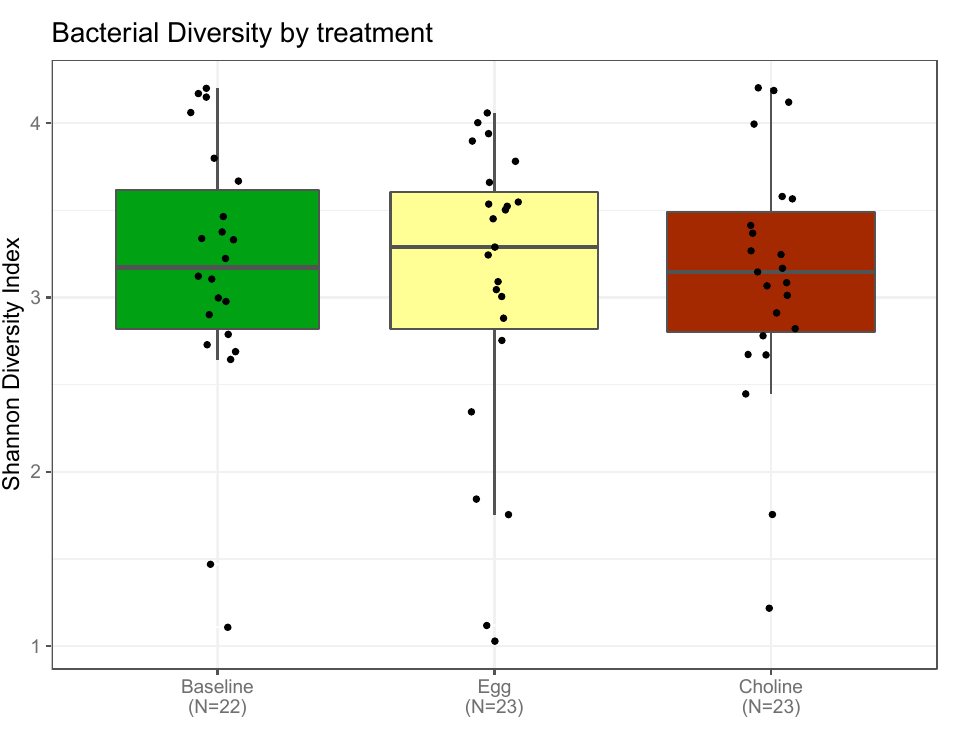
Figure 3. Alpha diversity was measured by Shannon diversity index in subjects with MetS at baseline and post-consumption of 3 eggs/d (P-Egg) or CB supplementation(P-CB) for 4 weeks. The solid bar indicates the mean, and the scattered point represents the variation among subjects. No significant changes were observed between the treatments. One of the samples for baseline due to errors during the preparation could not be included in this figure.